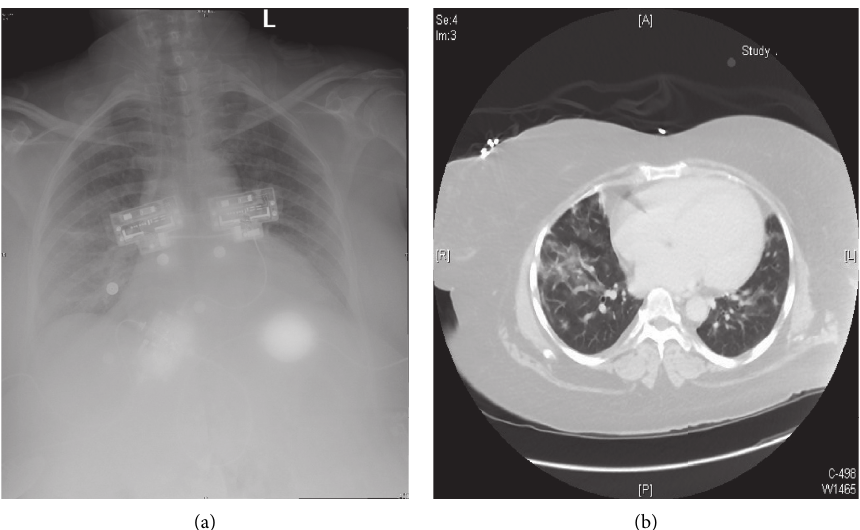
Figure 2: Chest X-ray demonstrating bilateral airspace opacities in the upper lung zones (a). CTchest demonstrating patchy ground-glass opacities (b).